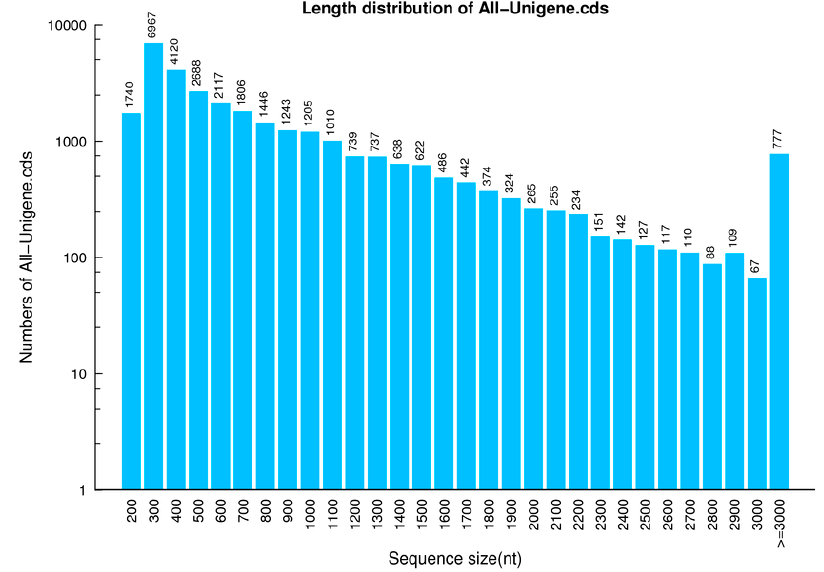
Figure 1. Unigene length distribution. The x-axis represents the length of unigenes. The y -axis represents the number of unigenes.